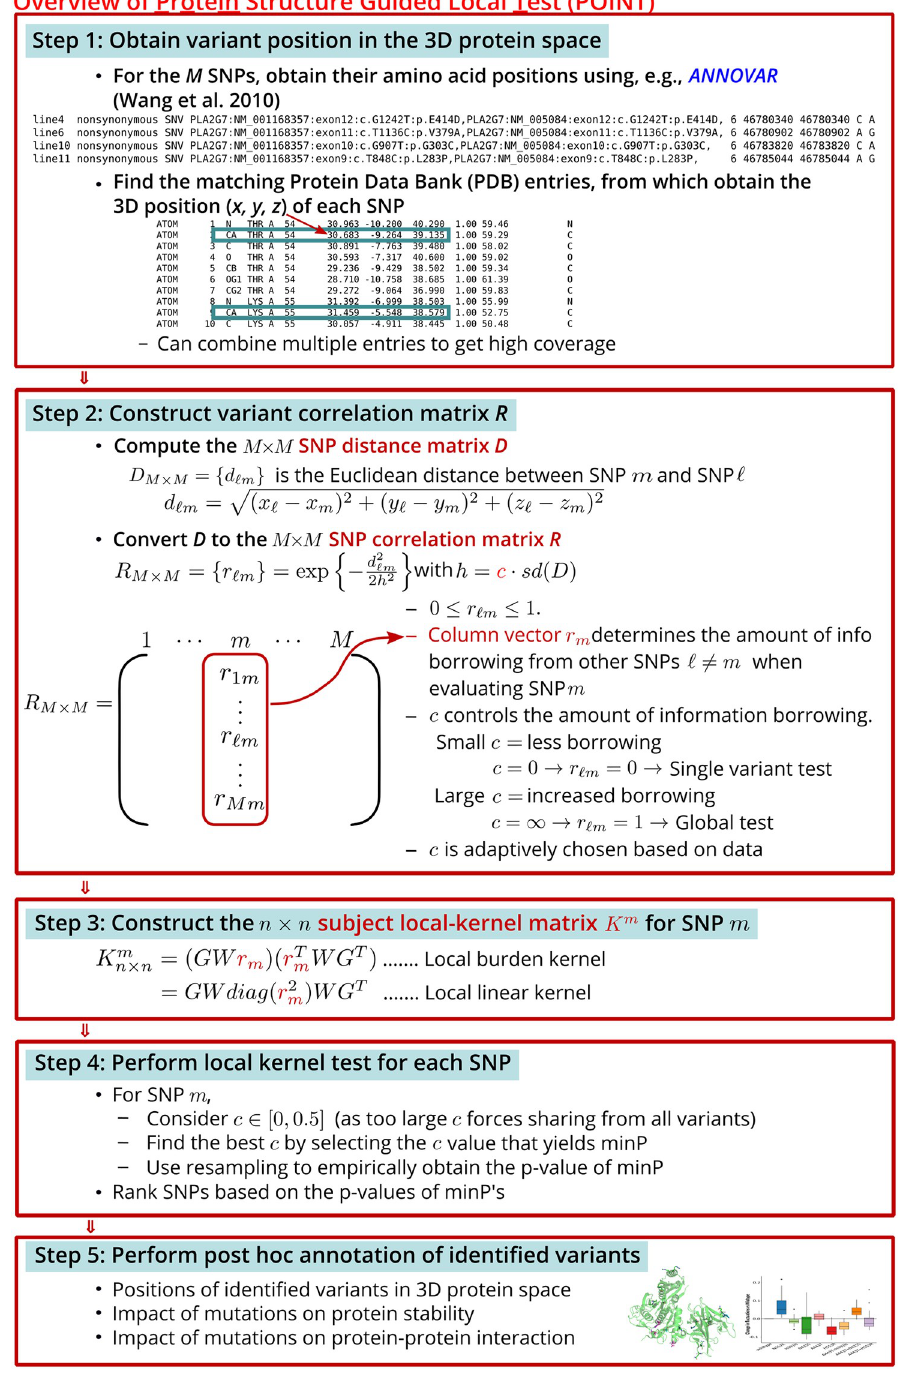
Fig 1. Overview of the protein structure guided local test